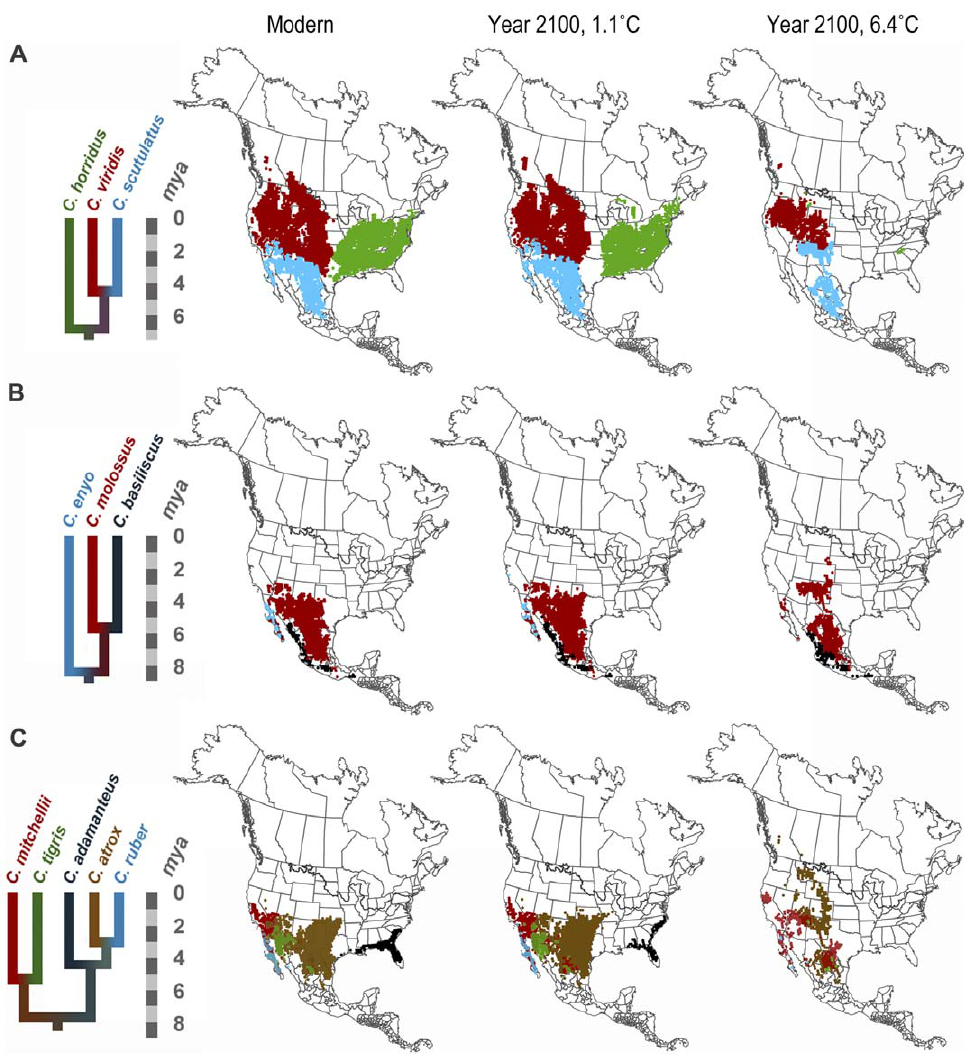
Figure 8. Current and future predictions of suitable habitat. Suitable habitat distributions were modeled under two future climate scenarios for the year 2100 for 11 rattlesnake species. The two climate scenarios are derived from an increase of mean annual temperature by 1.1 u C and by 6.4 u C. A, B, and C, Phylogeny and modeled suitable habitat distributions by clade.